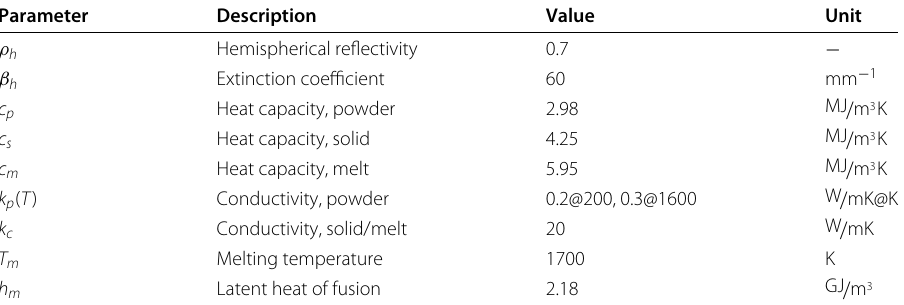
Table 2 Material parameters for single track